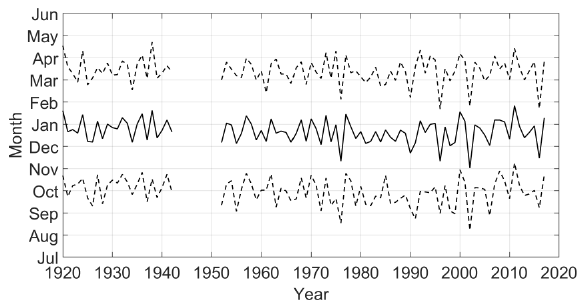
Figure 8. Temporal evolution of (a) dimensionless seasonal index (DSI; Feng et al., 2013) represented by a red line with a correspond- ing linear regression (dashed line). (b) Seasonality index (SI; Walsh and Lawler, 1981) represented by a green line with a corresponding linear regression (dotted line).